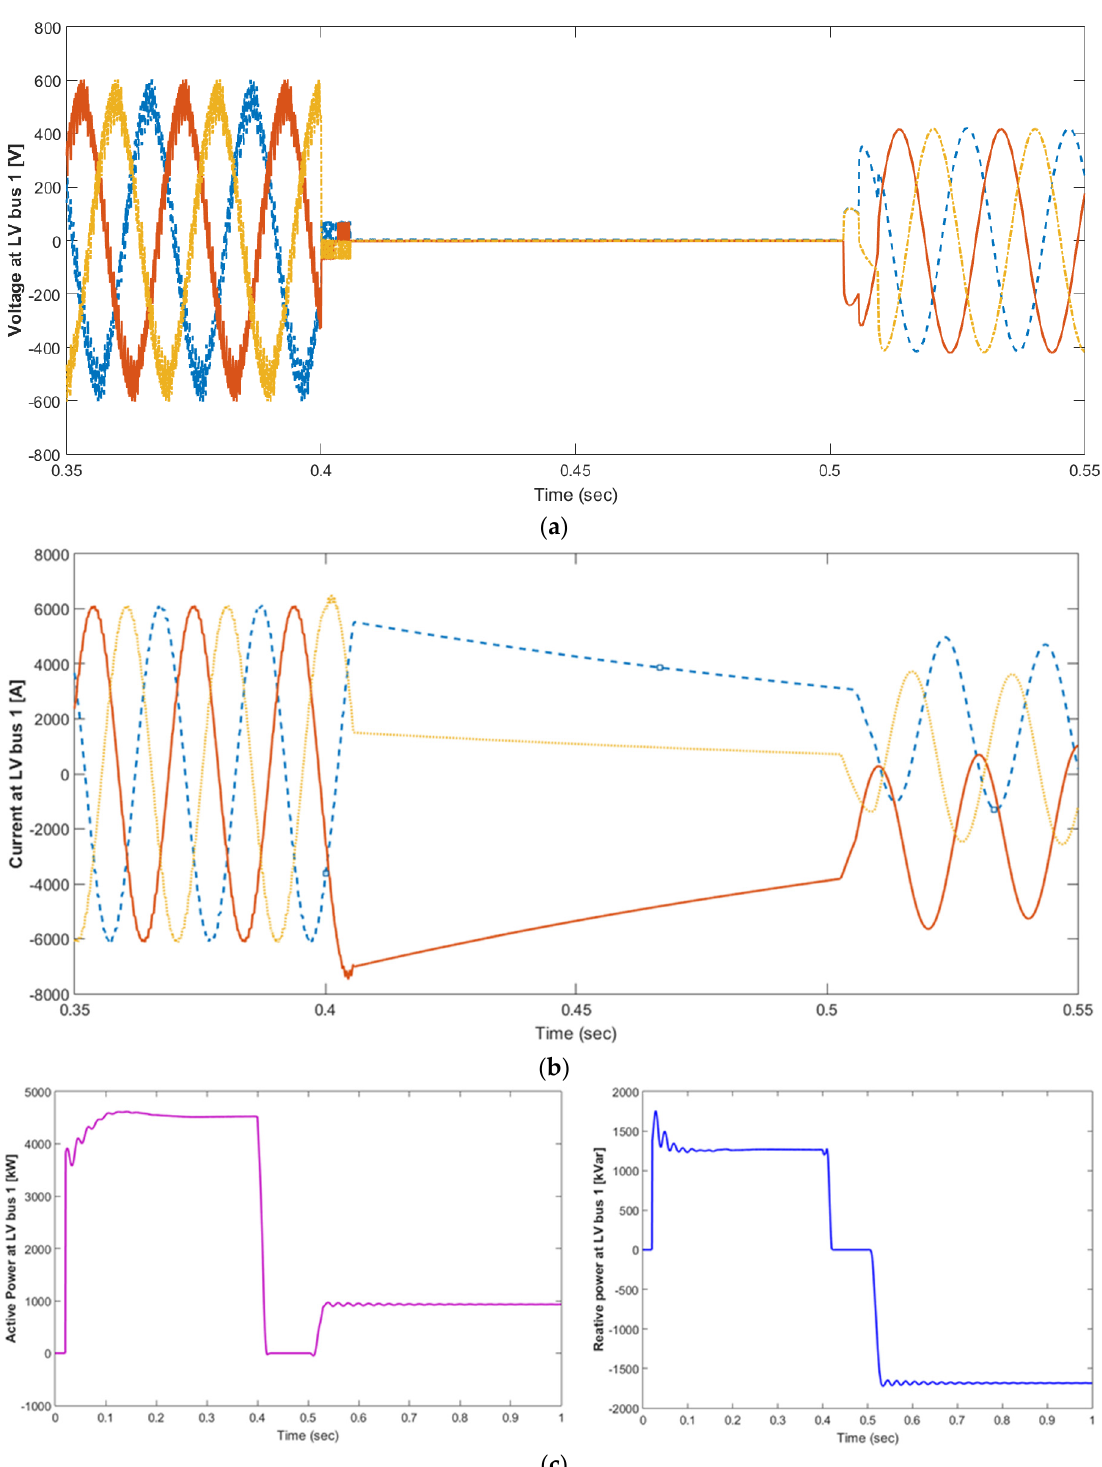
Figure 9. ( a ) Voltage in the low-voltage bus during a three-phase-to-ground fault. ( b ) Three-phase current at the low-voltage bus of one PV generator. ( c ). Supplied active and reactive powers of one PV generator at the low-voltage bus.